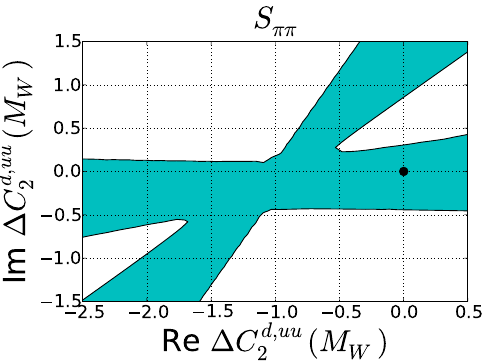
( M W ) allowed by the observable 2 ( M W ) is only weakly constrained and 1